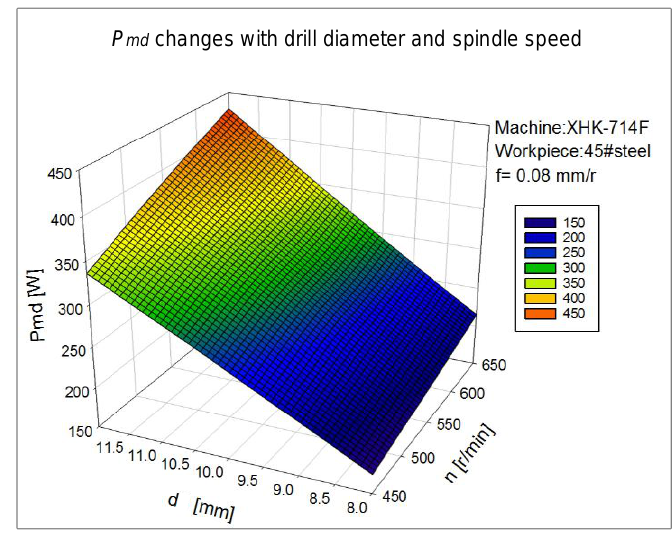
Figure 5. m d P changes with respect to drill diameter and spindle speed ( f = 0.08mm/r). Figure 5. P md changes with respect to drill diameter and spindle speed ( f = 0.08